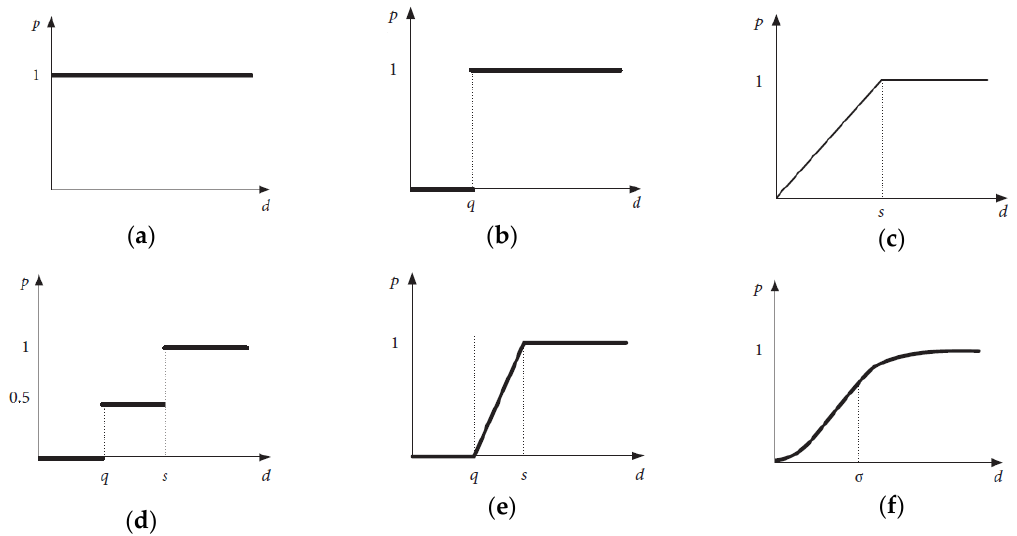
Figure 1. Function charts of criterion priorities: ( a ) function chart of the priorities of the usual criterion; ( b ) function chart of the priorities of the U-shape criterion; ( c ) function chart of the priorities of the V-shape criterion; ( d ) function chart of the priorities of the level criterion; ( e ) function chart of the priorities of the V-shape with indifference criterion; ( f ) function chart of the priorities of the Gaussian criterion.